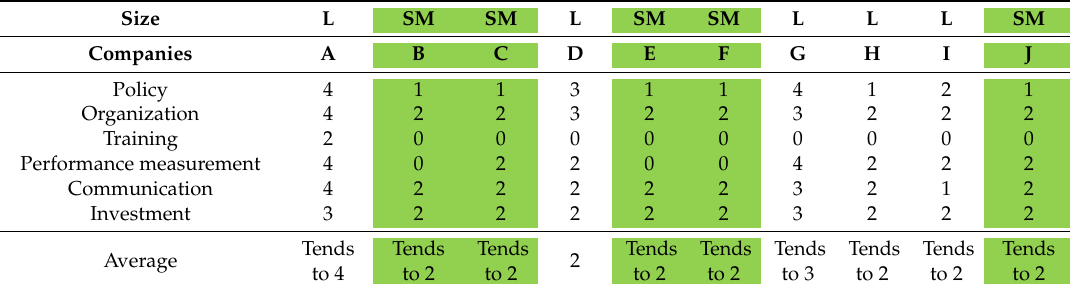
Table 2. EnM assessment model results.